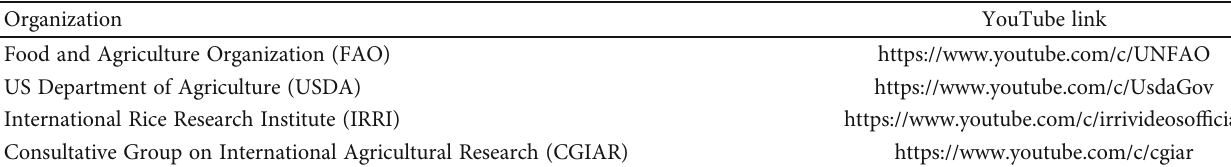
Table 1: YouTube Channel of di ff erent agricultural organization.